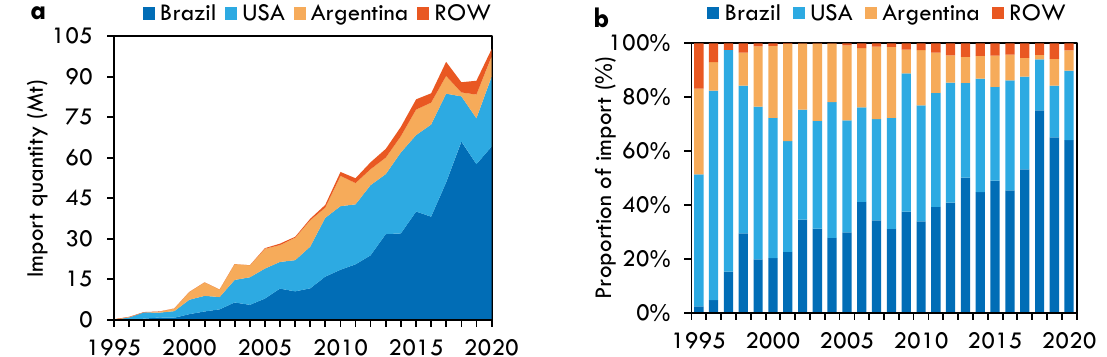
Figure 1. China’s soybean imports, 1995–2020 . ( a ) Quantity changes in China’s soybean imports from different sources. ( b ) Structure changes in China’s soybean imports from different sources. Source: Based on data from